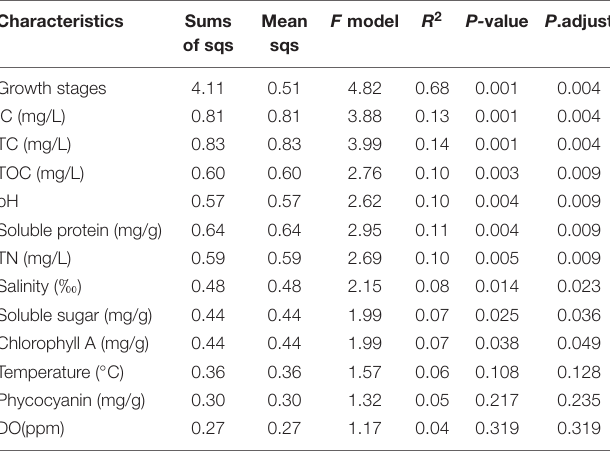
TABLE 2 | Effects of growth stage, environmental factors, and physiological parameters of U. fasciata on U. fasciata surface microbiota. Characteristics